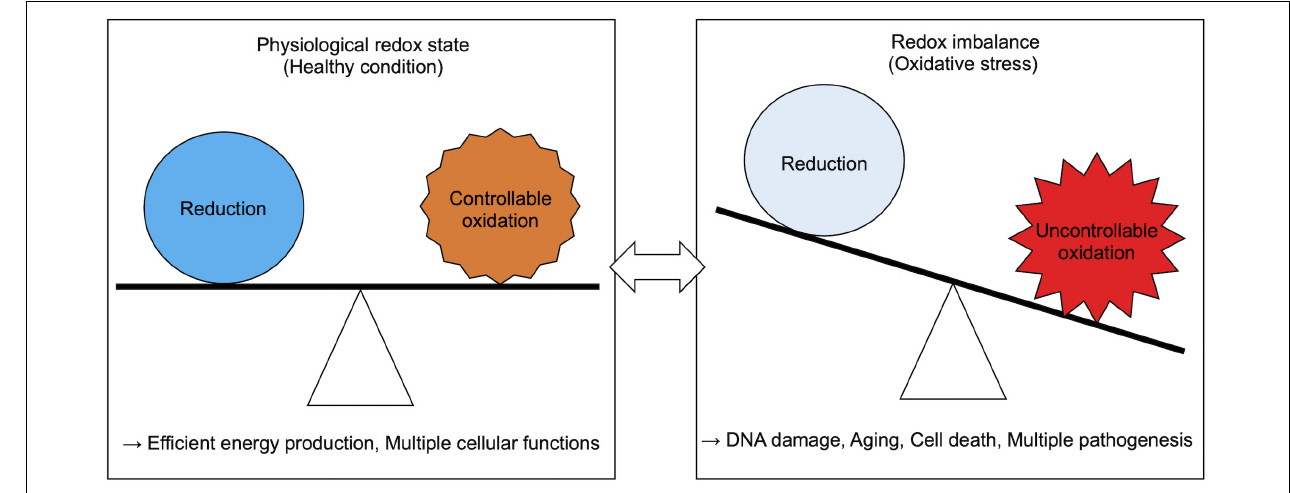
FIGURE 1 | Physiological and pathological cellular redox state.